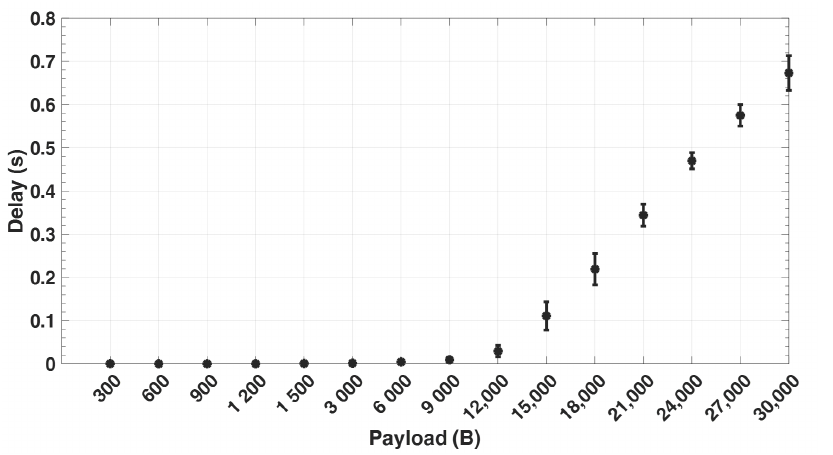
Figure 10. The average End-to-End